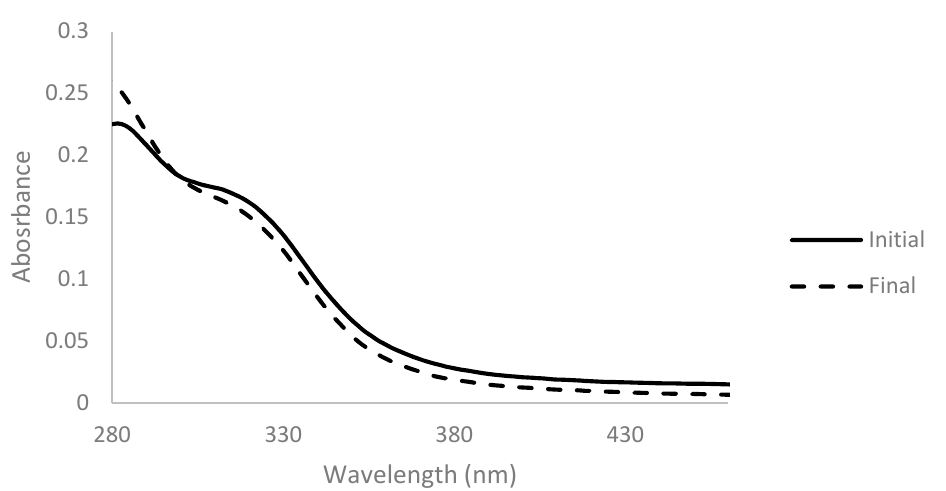
Figure 4. Absorbance spectra of arabinoxylan 2% ( w / v ) with 10% ( v / v final ) of hydrogen peroxide before (full line) and after 2 h of reaction time at 45 °C (dashed line), for a dilution ratio of 1:100. A lower absorbance of the solution in the 300-nm-onwards zone of the spectrum after reaction was noticed. This change was complemented with a change of the color of the solution, which shifted from a darker and brownish color to a lighter and yellow color (Figure 5).